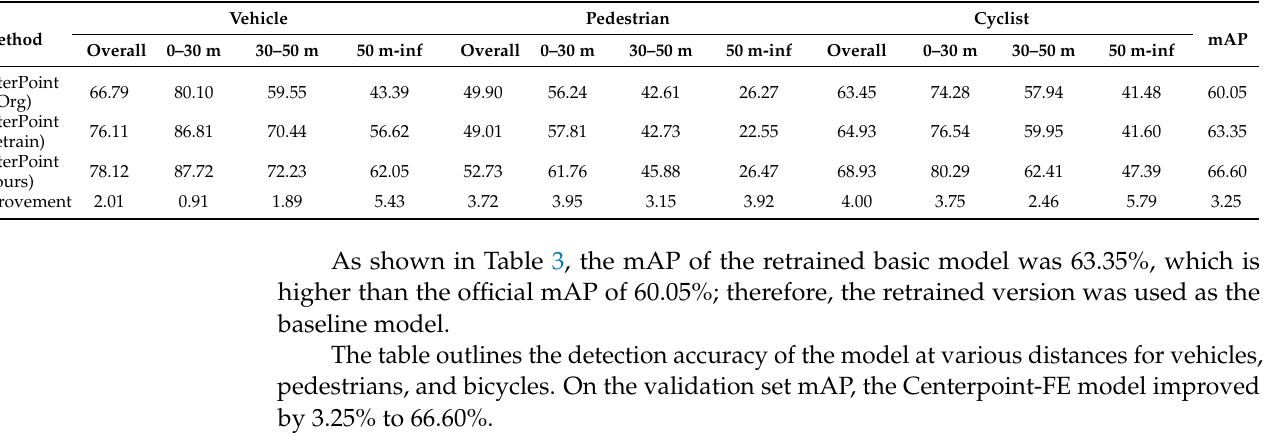
Figure 6. Visualization of YOLOv4-SDCM and YOLOv4 object detection with the KITTI data set.